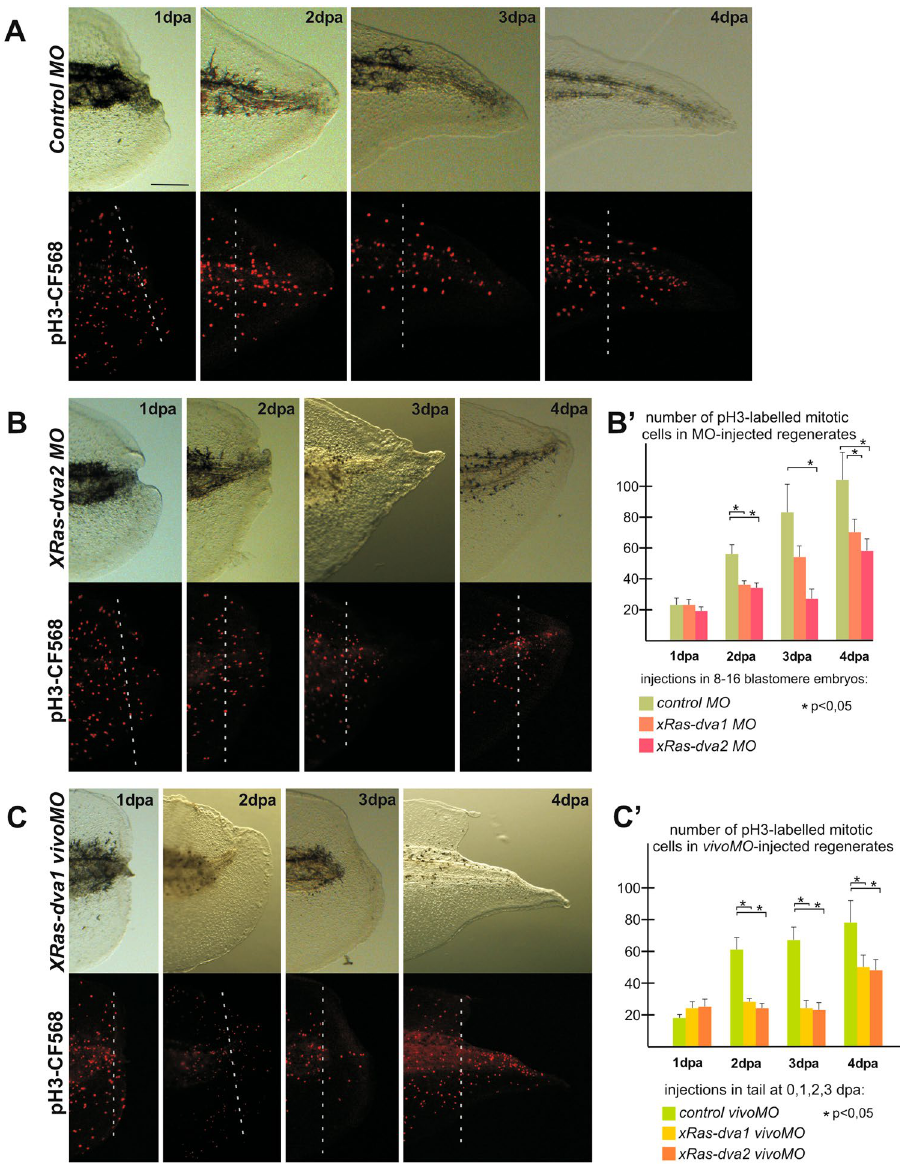
Figure 7. Analysis of mitotic cells patterns in amputated tails of tadpoles with normal and inhibited xRas- dva1 or 2 functioning during 1–4 dpa period. ( A – C ) Transmitted light and fluorescent images of distal areas of 1–4 dpa tails of tadpoles, developed from embryo injected by control MO ( A ) or x Ras-dva2 MO ( B ) or x Ras- dva1 vivoMO ( C ). ( A ) Immunostaining with primary rabbit anti-pH3 and secondary anti-rabbit antibodies conjugated with red fluorescent protein CF568 demonstrate gradual increase of mitotic activity in the regenerating area of tadpoles injected by control MO starting from 2 dpa (see B’ for statistics). ( B ) Transmitted light and fluorescent images of tadpoles injected by xRas-dva2 MO show inhibition of mitotic activity during 2–4 dpa. Scale bar 0,1 mm. (B’) Quantification of pH3-labbeled mitotic cells number in regenerates of 1–4 dpa tadpoles, developed from embryos injected by control , xRas-dva1 or xRas-dva2 MO . Data of five independent experiments (5 tadpoles of each injection type were used in 1 experiment) were used for statistical analysis, statistical significance was determined by paired t test, p < 0,05 (asterisk). Error bars indicate SD. ( C ) Transmitted light and fluorescent images of tadpoles injected by xRas-dva1 vivoMO show strong inhibition of mitotic activity during 2–3 dpa. (C’) Quantification of mitotic cells number in 1–4 dpa regenerates of tadpoles injected at 0, 1,2 dpa by control , xRas-dva1 or xRas-dva2 vivoMO . Data of five independent experiments (5 tadpoles of each injection type were used in 1 experiment) were used for statistical analysis, statistical significance was determined by paired t test, p < 0,05 (asterisk) Error bars indicate